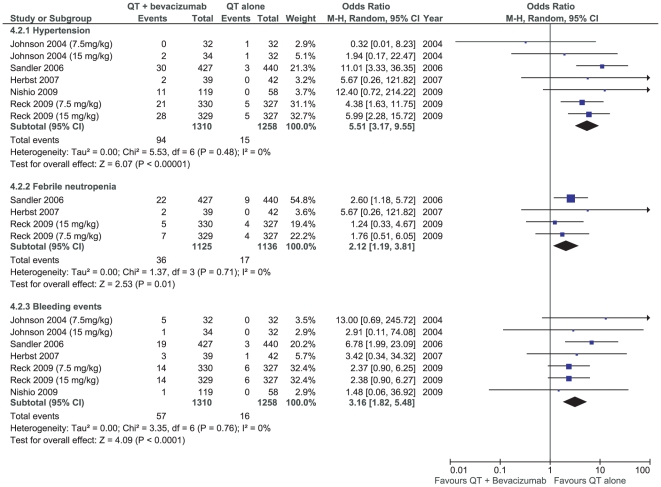
Meta-analysis of grade 3/4 toxicities.